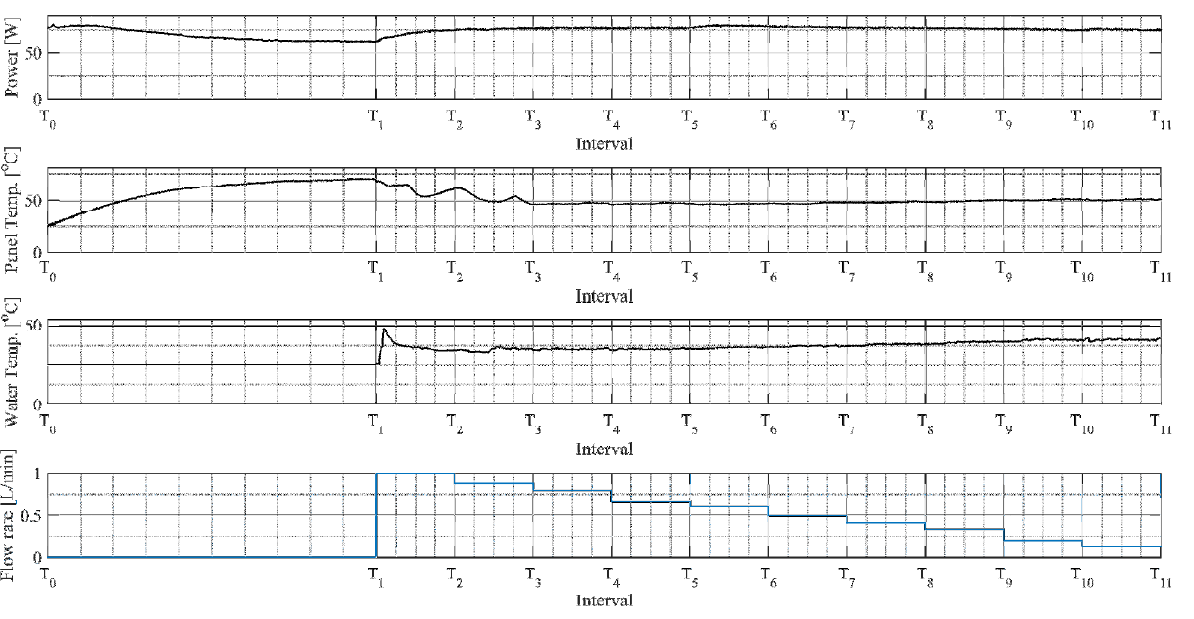
Fig. 9. Data from the case study